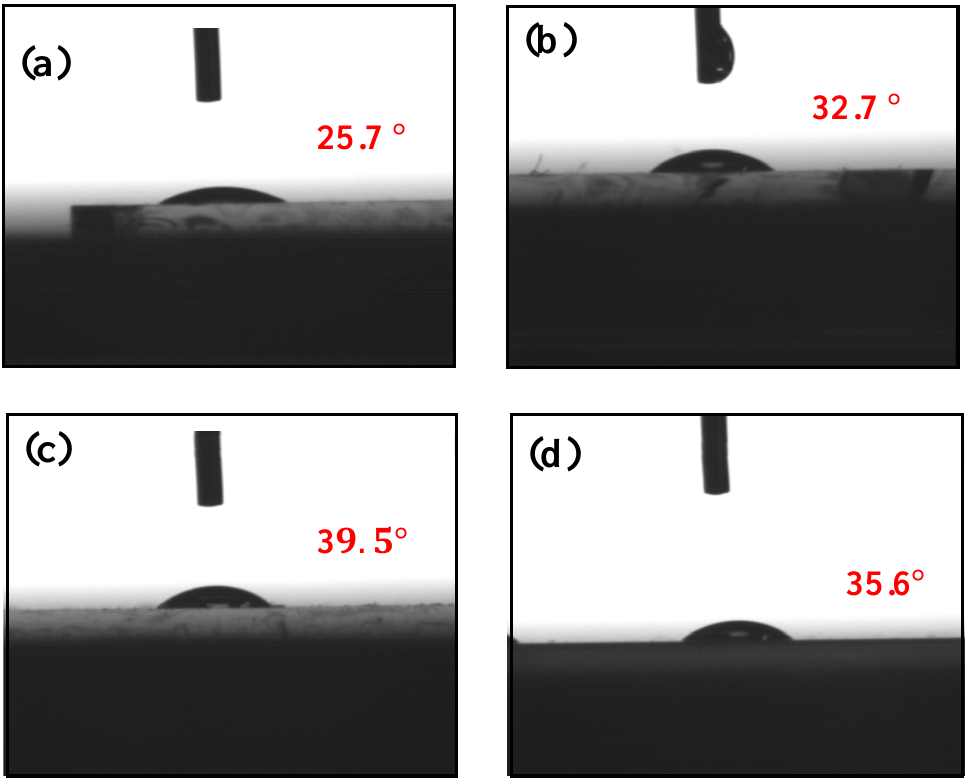
Figure 6. Contact-angle measurements with methane for ( a ) PEDOT: PSS, ( b ) PEDOT: PSS–sorbitol, ( c ) PEDOT: PSS–maltitol, and ( d ) PEDOT: PSS–sorbitol–maltitol.